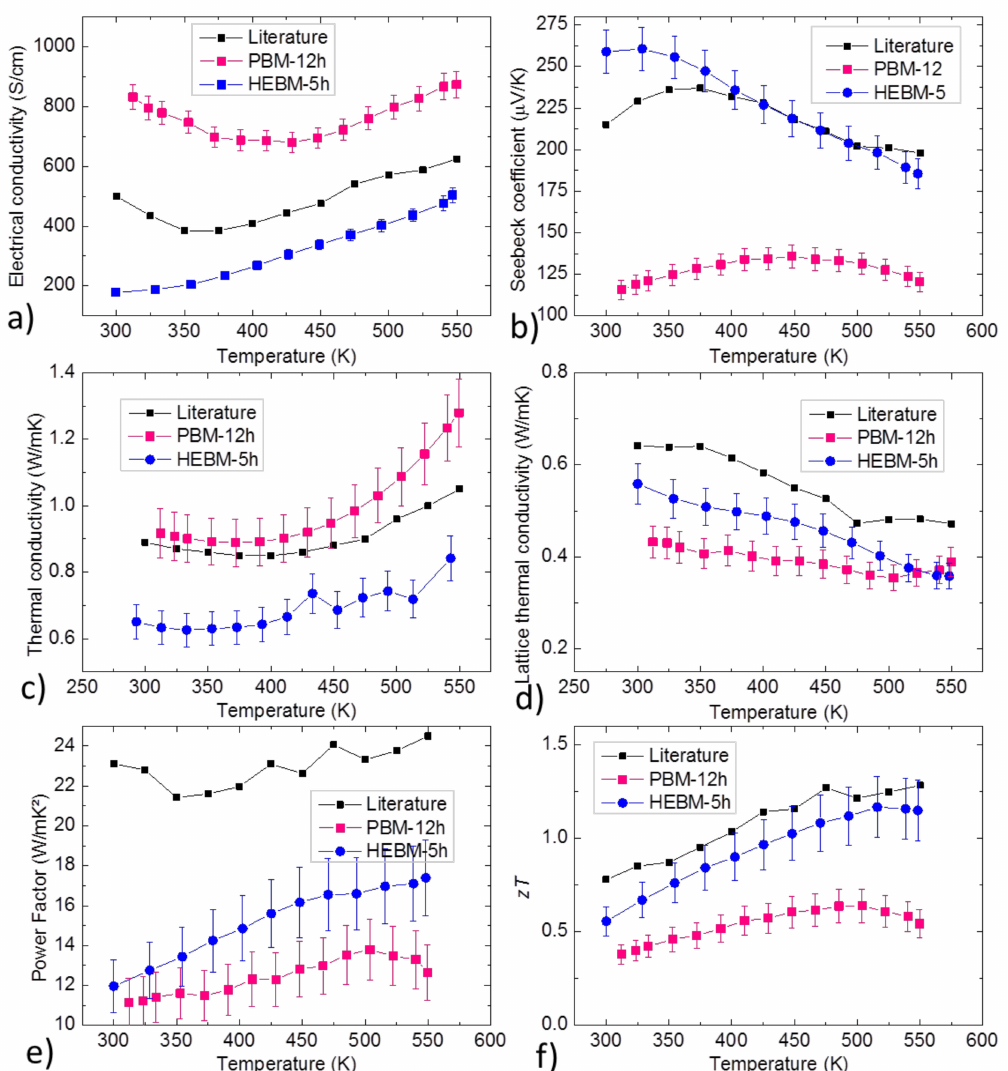
Figure 3. Temperature dependent ( a ) electrical conductivity, ( b ) Seebeck coe ffi cient, ( c ) thermal conductivity, ( d ) lattice thermal conductivity, ( e ) power factor and ( f ) figure of merit of sintered PBM and HEBM samples. Literature values are taken from Liu et al.